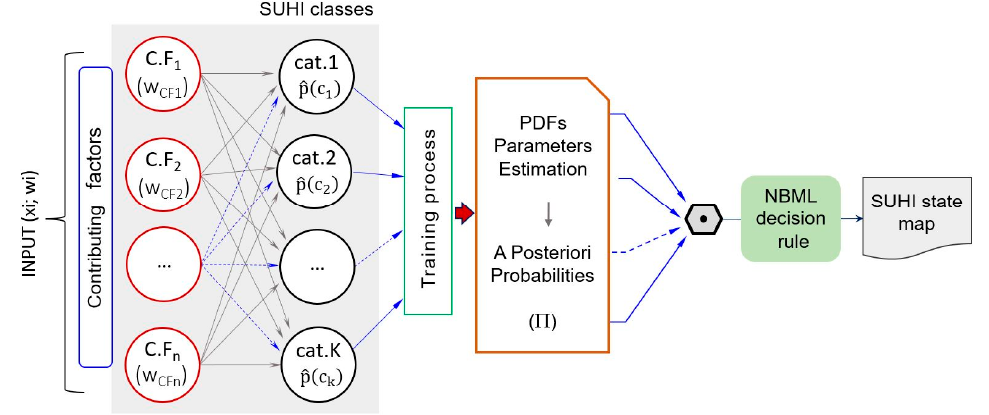
Figure 6. Architecture of the NBML modelling for generating the SUHI product.